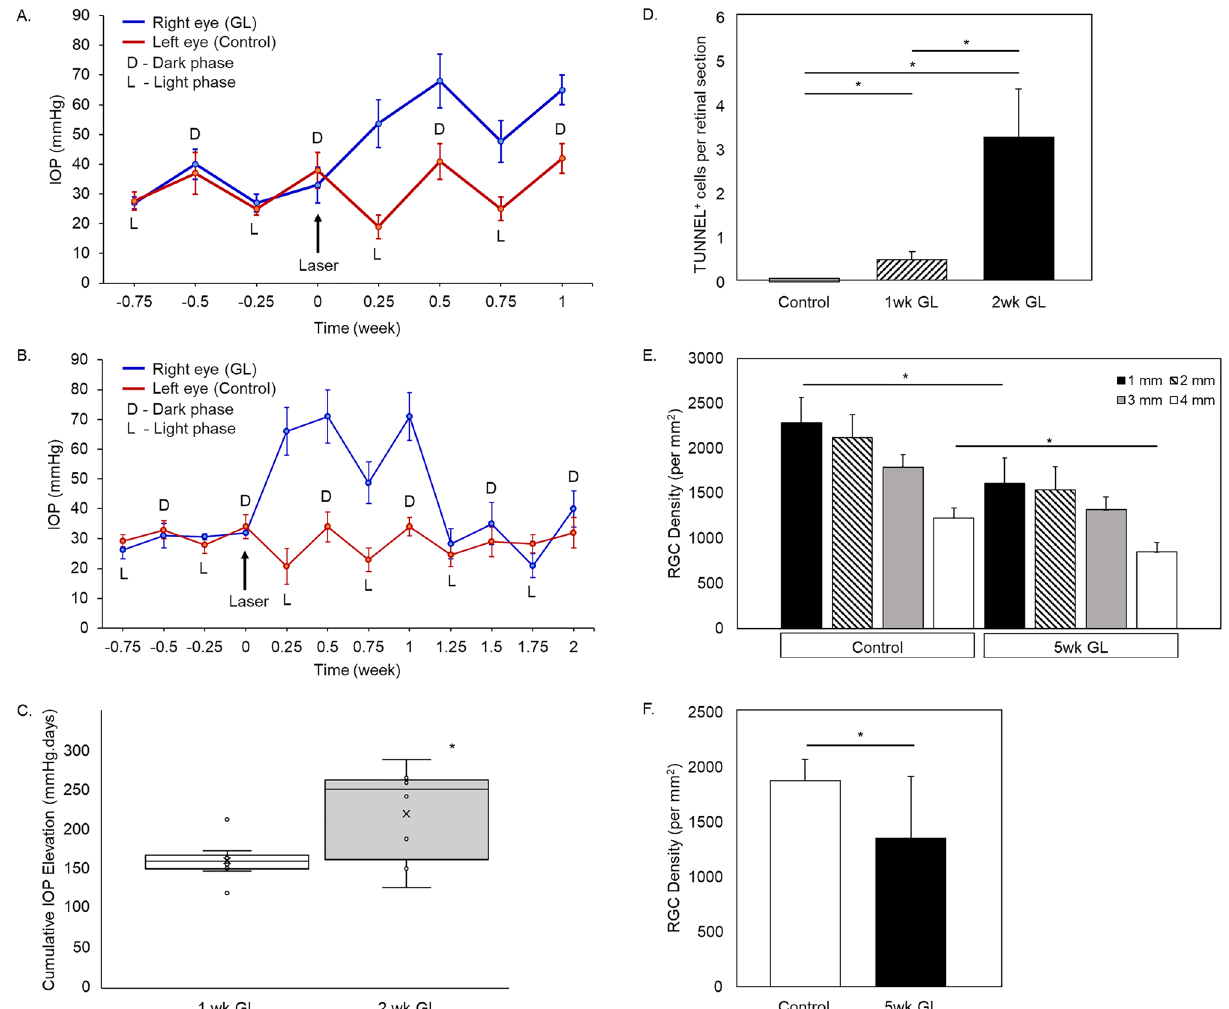
Figure 1. The light and dark phase IOP profiles for laser-treated and contralateral control eyes. Trabecular laser photocoagulation resulted in a significant increase of IOP during 1 ( A ; n = 10) and 2 ( B ; n = 10) weeks after the procedure compared to untreated contralateral eyes. IOP profiles of representative animals of 1 and 2 weeks after laser photocoagulation were shown. RE, right eye; LE, left eye. ( C ) Comparison of cumulative IOP elevation at 1 week and 2 weeks after trabecular laser photocoagulation. There is a significant increase in cumulative IOP elevation at 2 weeks after photocoagulation compared to 1 week group (n = 10; P = 0.012). Each circle in the bar chart represents individual data points. ( D ) Quantification of TUNEL-positive RGCs in control and glaucomatous retinas 1 and 2 weeks after IOP elevation. TUNEL staining was performed on retinal sections from control (n = 6) and experimental eyes 1 (n = 3) and 2 (n = 3) weeks of IOP elevation. The number of TUNEL-stained ganglion cells per eye was determined from at least 6 representative sections. TUNEL- positive cells were detected in glaucomatous retinas 1 and 2 weeks after IOP elevation, but not in control retinas. The difference in the number of TUNEL-positive cells between eyes with elevated IOP and controls eyes was statistically significant (* P < 0.05). E. RGC loss 5 weeks after IOP elevation. Approximately 30% of cell loss in experimental retinas (n = 8) compared to controls (n = 8) was observed: 29.4% ( P = 0.023), 27.3% ( P = 0.053), 26.5% ( P = 0.061) and 30.8% ( P = 0.022) RGC loss at 1, 2, 3 and 4 mm from the center of the optic nerve, respectively ( E ). ( F ) Average RGC density 5 weeks after trabecular laser photocoagulation. There was a significant reduction in the average RGC density for the entire retinas after 5 weeks of IOP elevation compared to controls ( P = 0.035). Data are presented as mean ± SD. 1 wk GL, 1 week glaucoma; 2 wk GL, 2 weeks glaucoma; 5 wk GL, 5 week nuclear layer (ONL), which contains rod and cone photoreceptor nuclei, or in the inner plexiform layer (IPL), where dendrites of bipolar, amacrine and ganglion cells form synaptic connections. Staining in blood vessels was due to non-specific reactivity with secondary antibodies (Supplementary Fig. S1). The GCL in the mouse retina contains cell bodies of RGCs and displaced amacrine cells in an approximately 1:1 ratio (~ 45% RGCs and ~ 55% displaced amacrine cells) 27,28 . Rbpms, an established marker of RGCs 29 , was used to determine the identity of 8OHdG/8OHG-positive cells in the GCL. In both control and experimental samples, 8OHdG/8OHG staining